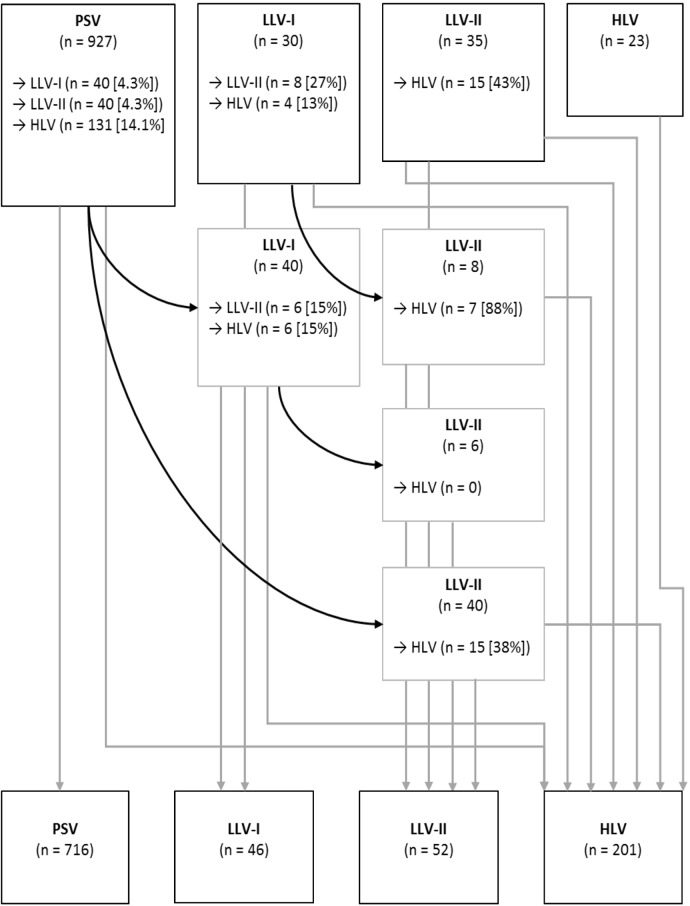
Flowchart illustrating patients changing viremia categories during follow-up.The top of the figure represents viremia categories at inclusion and the lower part shows how patients changed categories during the follow-up time. Reclassification was only made to higher viremia strata, and the reclassified subjects remained in that strata for the remaining follow-up period (unless progression to a higher viremia stratum occurred). Abbreviations: PSV–permanently suppressed viremia; LLV-I–low-level viremia 50–199 copies/mL; LLV-II–low-level viremia 200–999 copies/mL; HLV–high-level viremia.